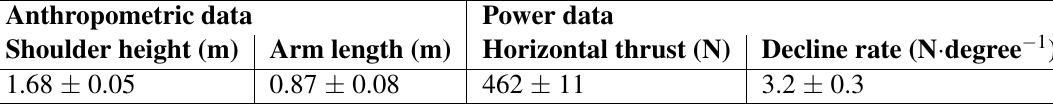
Table 1 List of human test data and strength data of athletes.